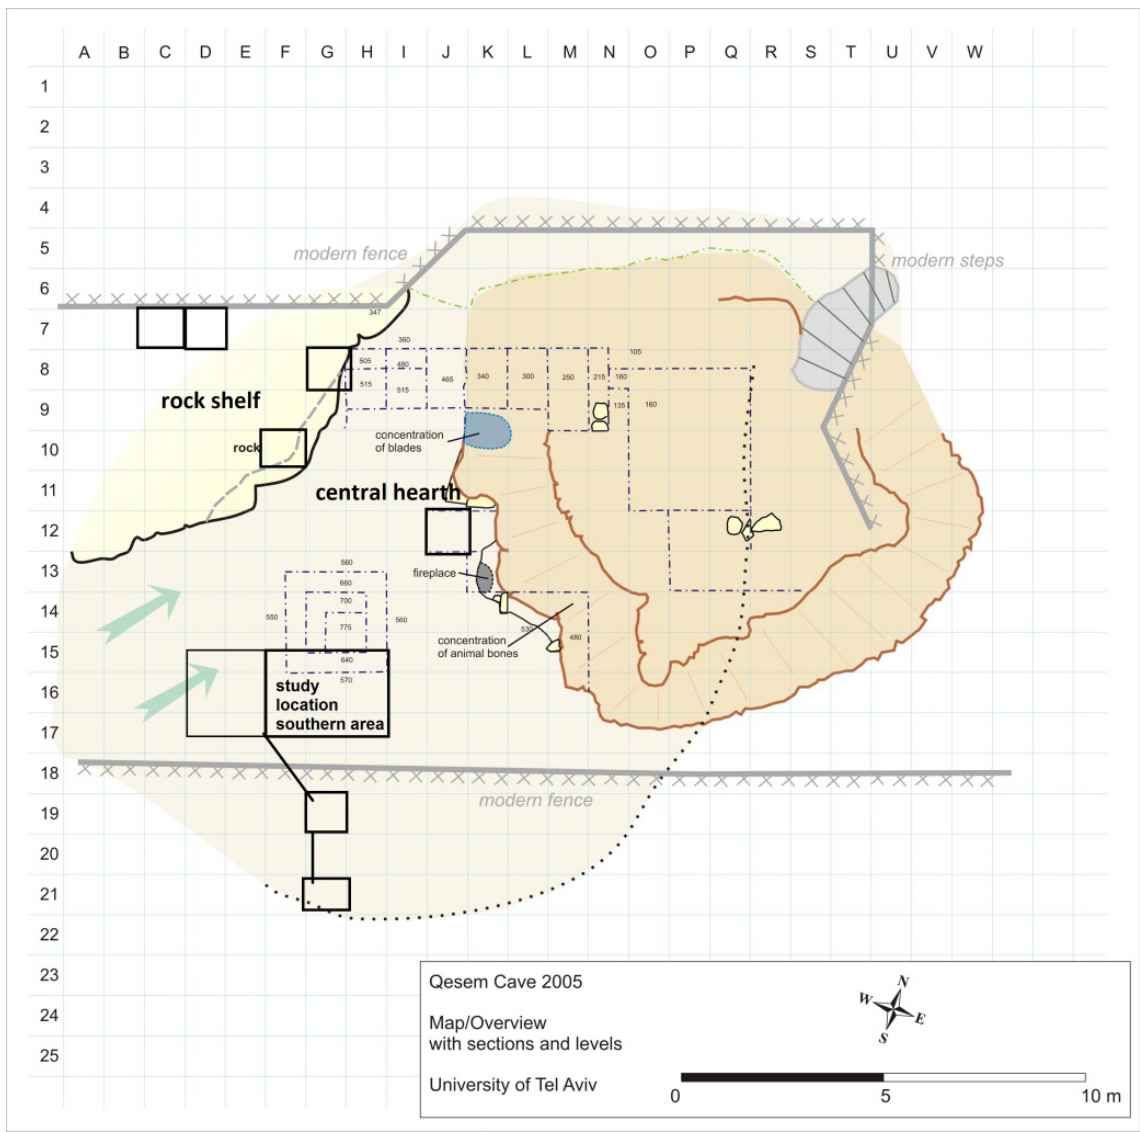
Figure 5. Plan view of Qesem Cave, including the excavation grid. The light-brown area corresponds to the lower sequence, whereas the dark-gray area corresponds to the upper one. The arrows mark the former entrance of the cave. The areas in which the pebbles were found are marked by black